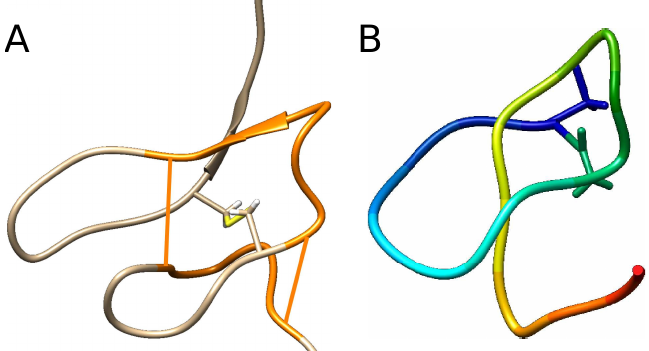
Figure 1. ( A ): Cysteine knot motif. The closed loop (orange) is formed by two disulfide bonds (straight stripes) and the main chain. The third cysteine bond, which pierces the closed loop, is shown explicitly. ( B ): Schematic depiction of the miniprotein Microcin J25. The loop is closed by an amide bridge (to facilitate the view, only bridge-forming residues are shown in atomic